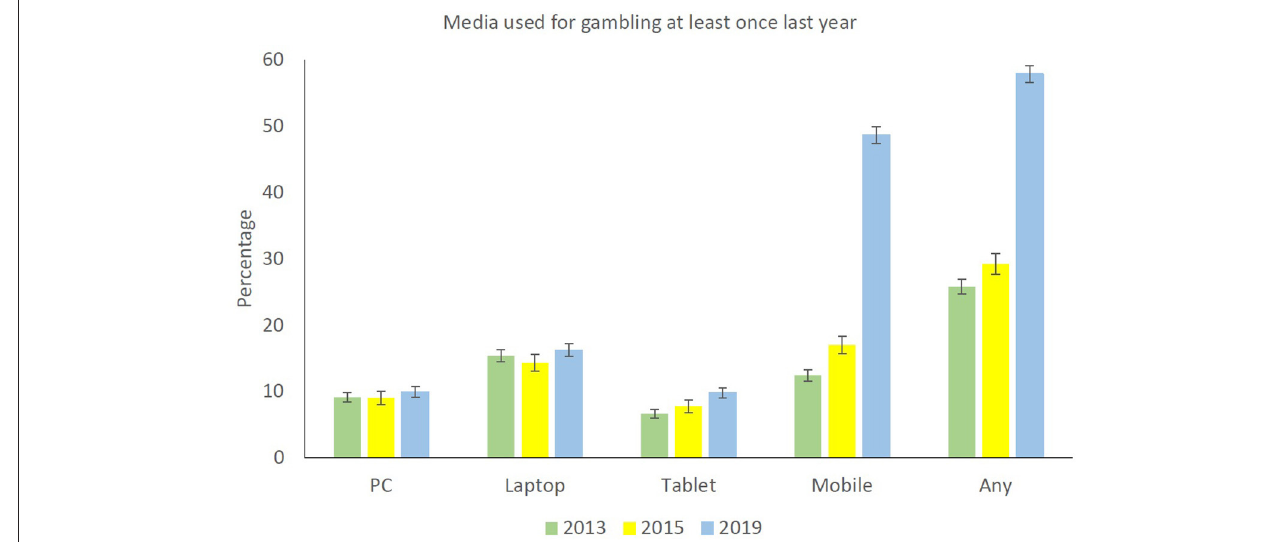
FIGURE 1 | Online gambling at least once last year among gamblers, broken down by year and mode of Internet access for gambling.